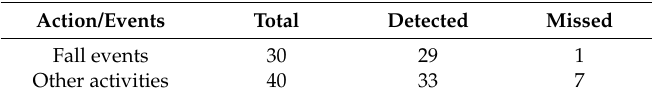
Table 1. Results of the proposed algorithm on the URFD dataset.